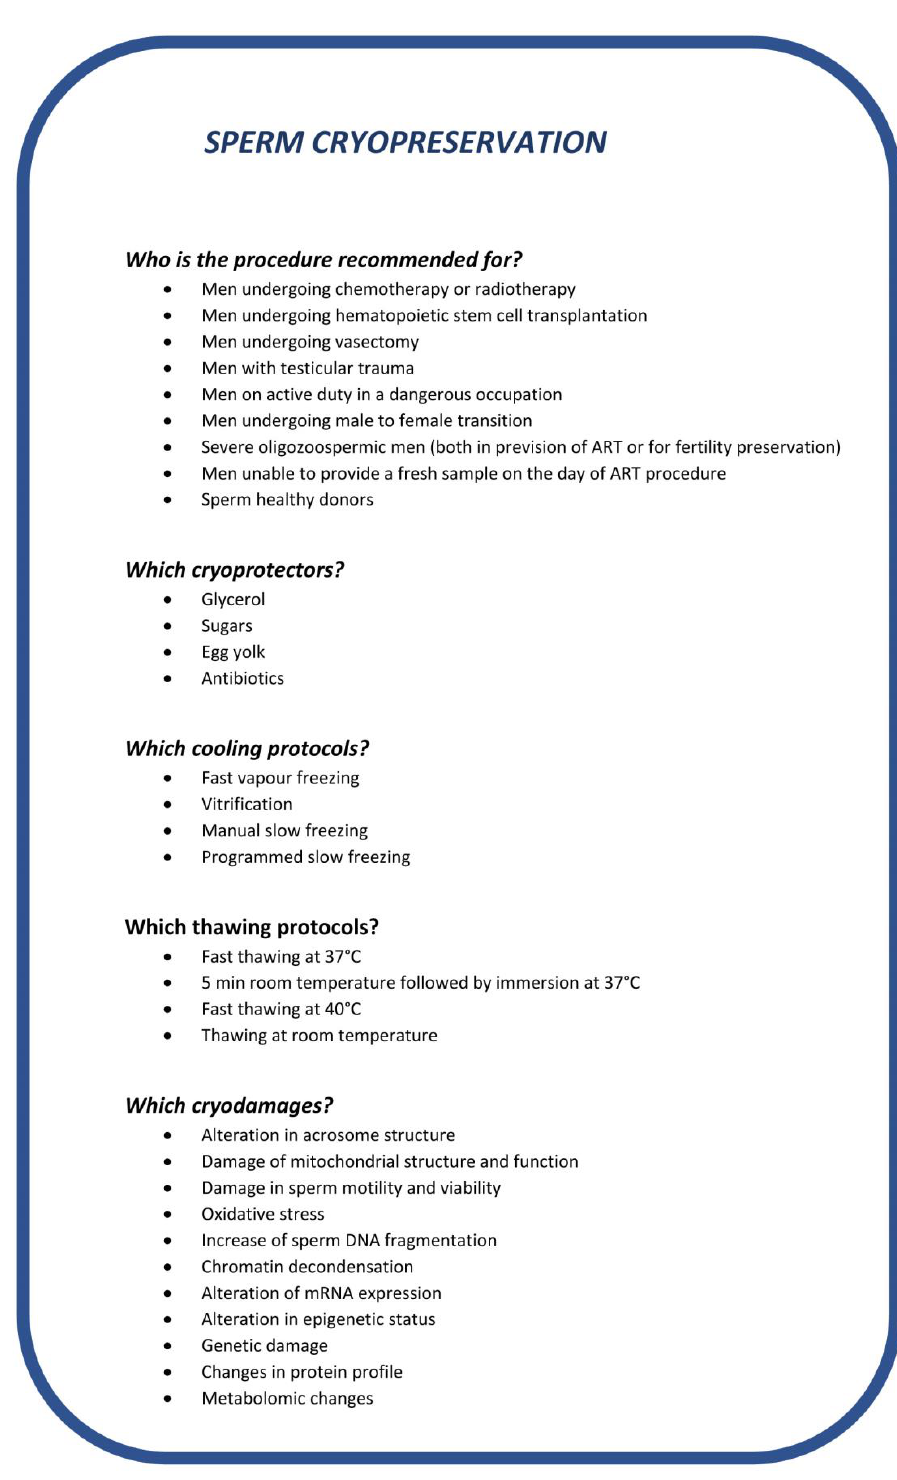
Figure 1. Schematic representation of categories of subjects to whom sperm cryopreservation is advised, cryoprotectants, cooling and thawing protocols which can be used and cryodamages that may occur.